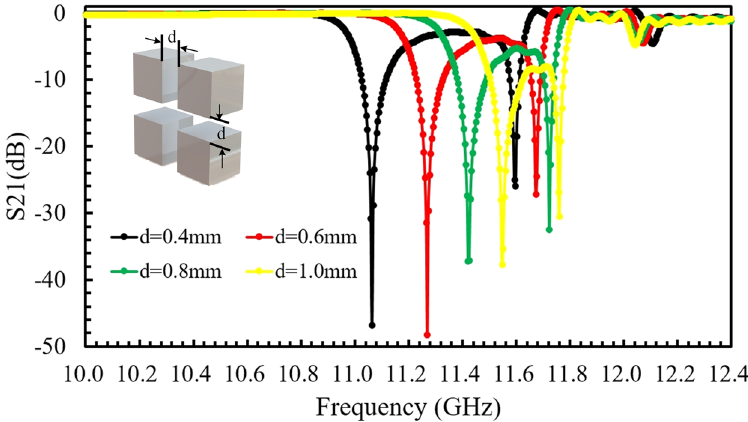
Figure 2. The relationship between the first order resonance frequency and the width of the intermediate layer.